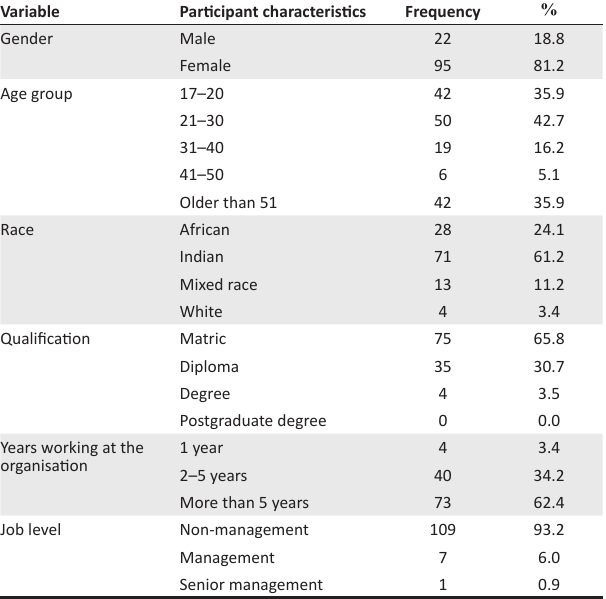
TABLE 1: Demographic characteristics of the participants. Variable Participant